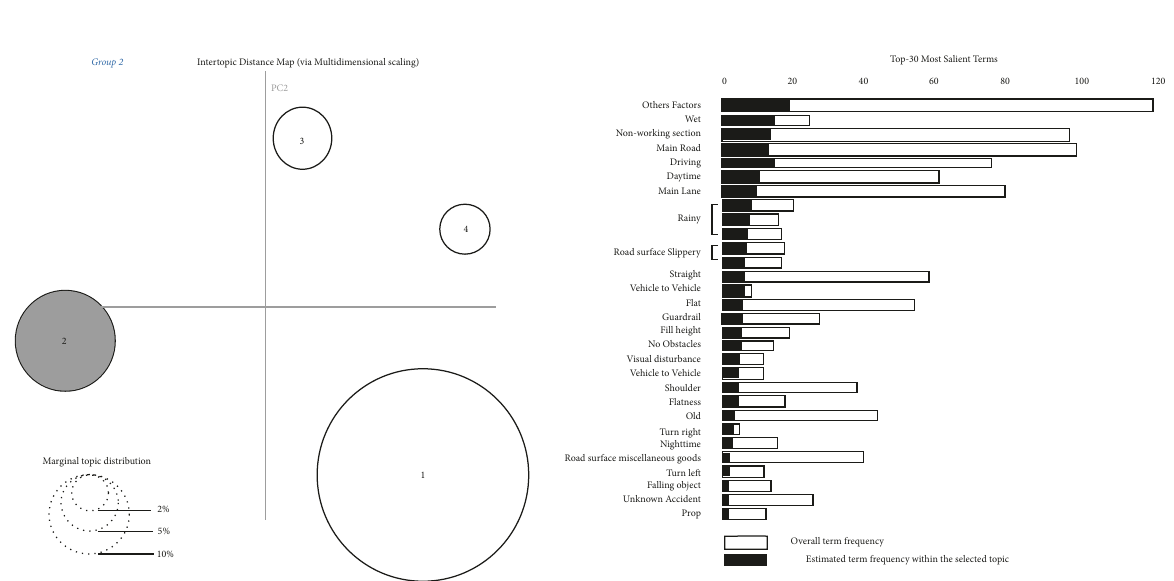
Figure 12: Other factor group 2.